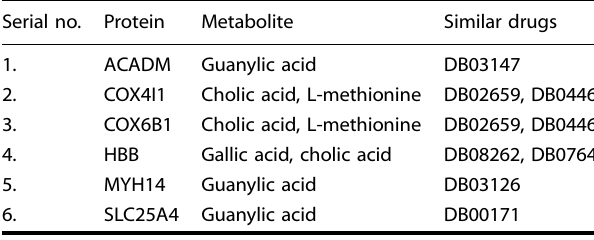
Table 2. Potential network